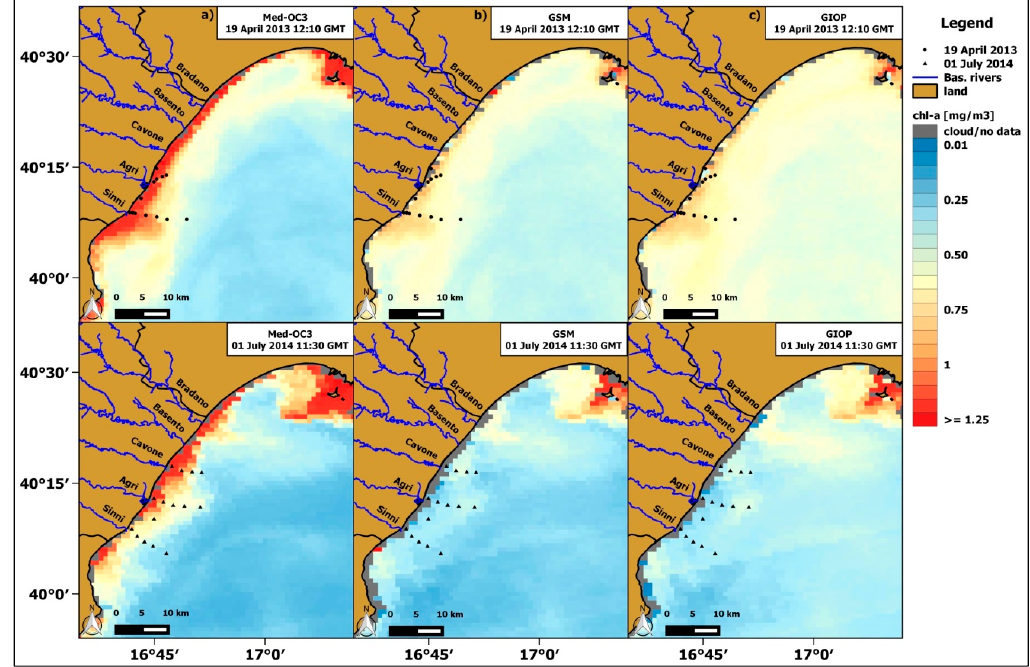
Figure 3. Daily chl-a maps derived from MODIS-Aqua using ( a ) Med-OC3, ( b ) GSM, ( c ) GIOP for 19 April 2013 (top panel) and 1 July 2014 (bottom panel).